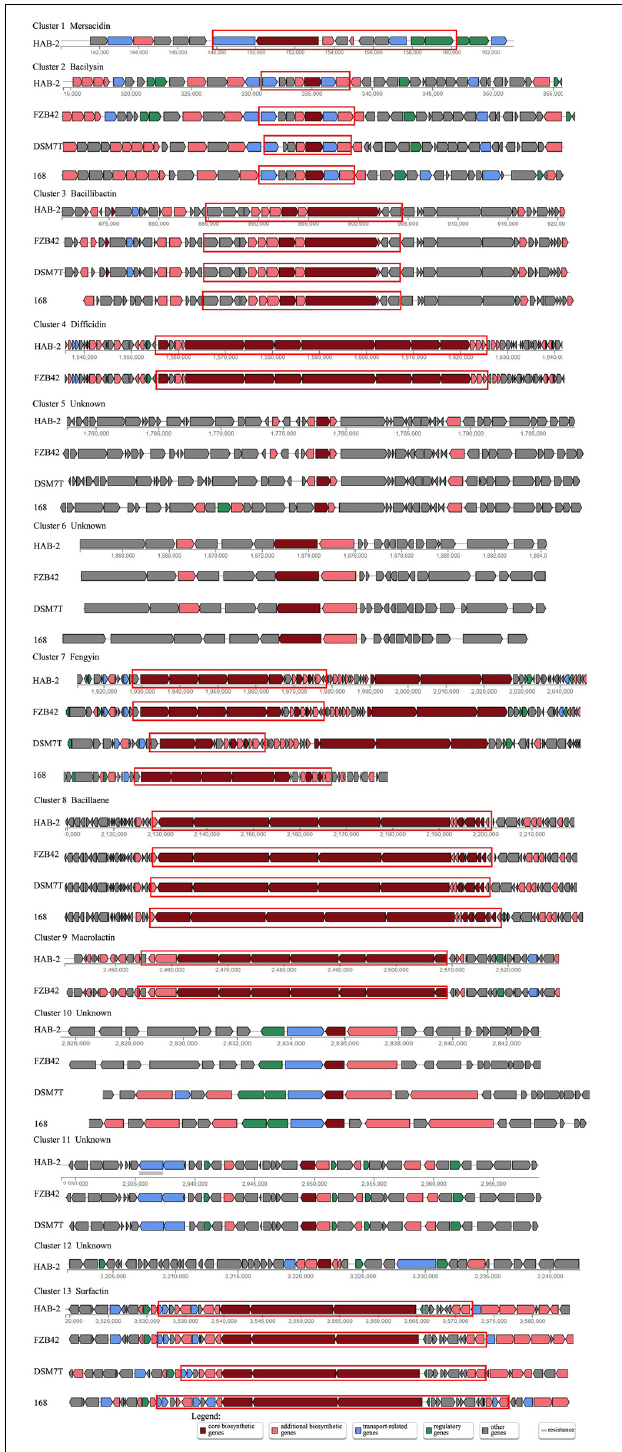
FIGURE 8 | Comparison of biosynthetic gene clusters from B. velezensis HAB-2 with B. velezensis FZB42, B. amyloliquefaciens DSM7 and B. subtilis 168. Different genes are filled with different colors: red indicates core biosynthetic genes, pink indicates biosynthetic genes, blue indicates transport-related genes, green indicates regulatory genes and gray indicates other genes. The red circled area is the core biosynthetic